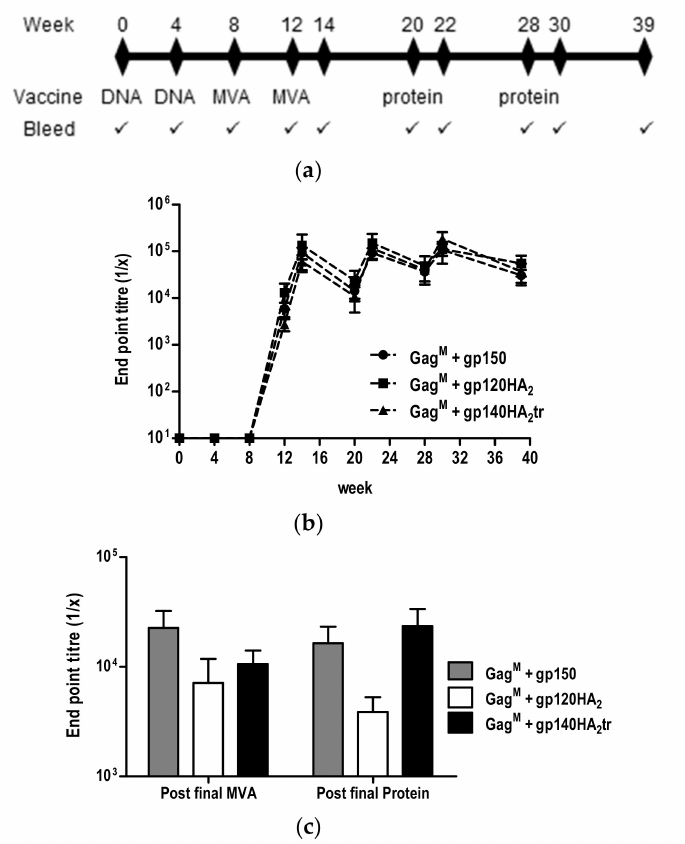
Figure 6. Vaccination schedule and characterization of binding antibodies induced in immunized rabbits. ( a ) Rabbit vaccination regimen. ( b ) Binding antibody titers in sera were quantified in an indirect ELISA using CAP256 SU gp140 trimers as the capture antigen. ( c ) Titers of binding antibodies to sca ff olded CAP256 SU V1V2 loop at week 14 (post final MVA) and week 39 (post final